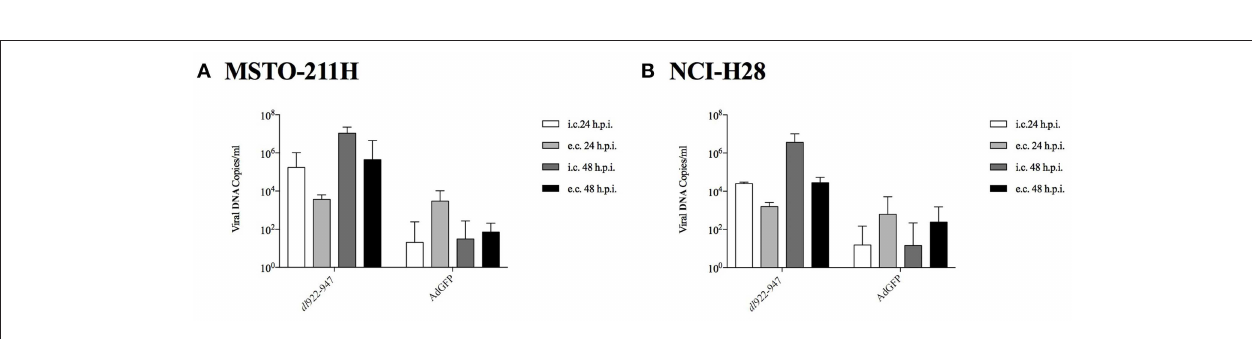
FIGURE 2 | MSTO-211H (A) and NCI-H28 (B) cells were infected with dl 922-947 and the non-replicating AdGFP. 24 and 48 hpi supernatant and adherent cells were collected separately to evaluate, respectively, extracellular (e.c.) released and intracellular (i.c) viral particles. Viral DNA was then extracted and used to quantify viral titer by Real-Time PCR. The data represent the mean of three different